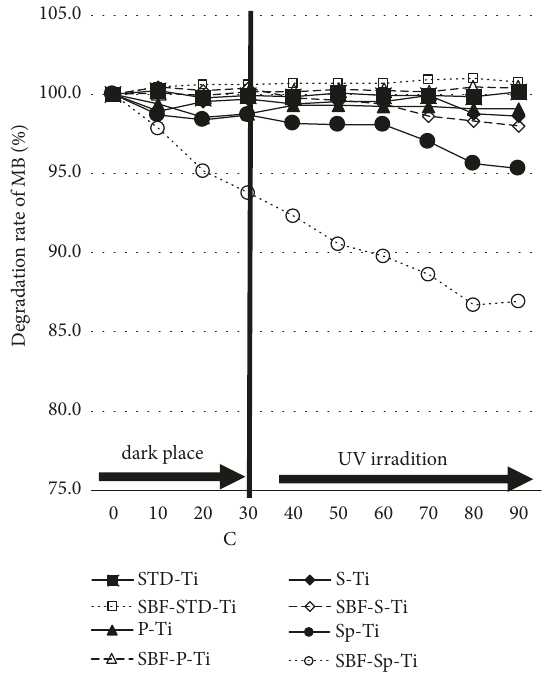
Figure 9: Changes in concentrationof Mb in aqueous solution with immersion of the Ti samples, with and without UV light.